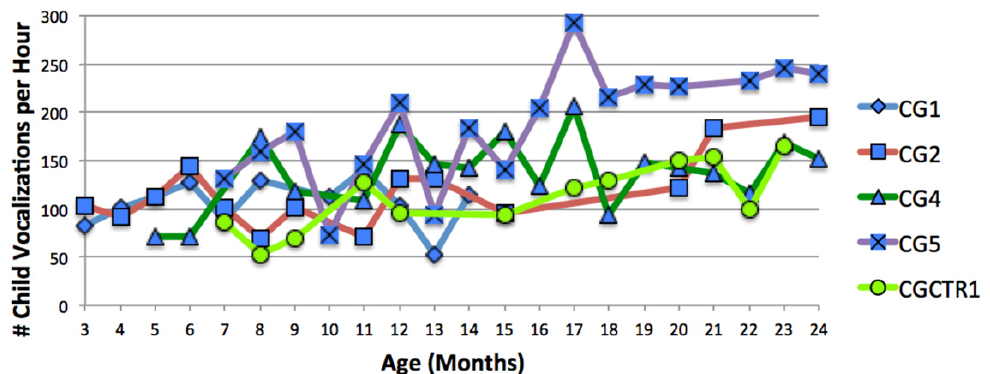
Figure 5. Number of child vocalizations per hour for ages 3 through 24 months for the four children with CG in the treatment cohort (blue symbols) and the control child with CG (green symbols).